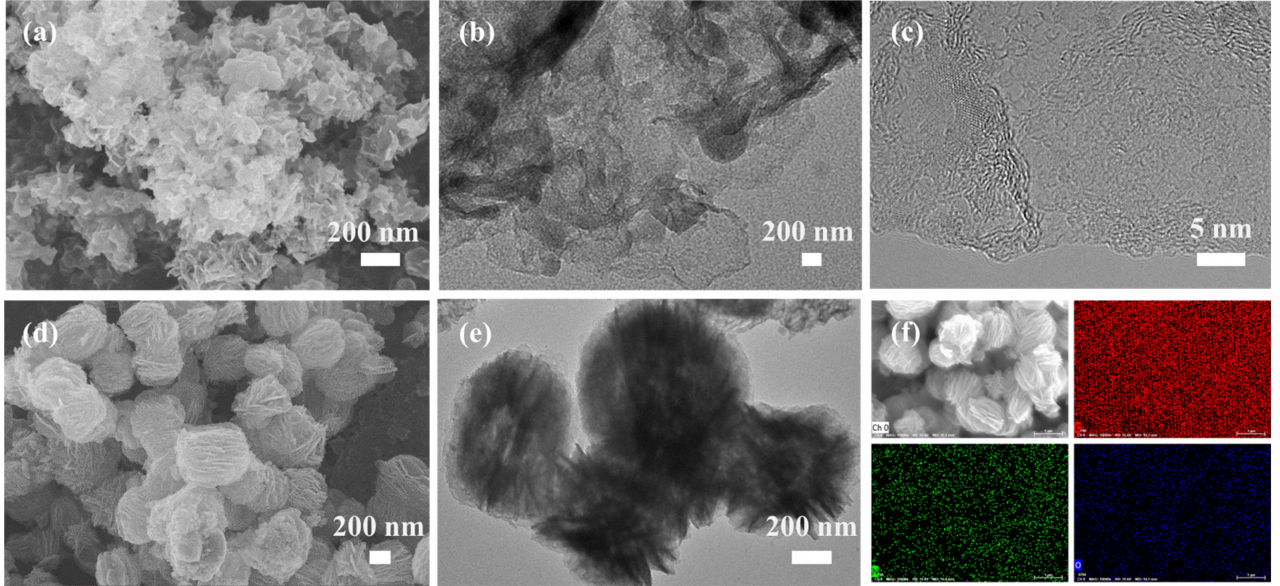
Figure 4. ( a ) SEM image of MCNS; ( b ) TEM image MCNS; ( c ) HRTEM images of MCNS; ( d ) SEM image of BMHCS; ( e ) TEM image of BMHCS; ( f ) The corresponding elemental mapping of C, N, O elements on the